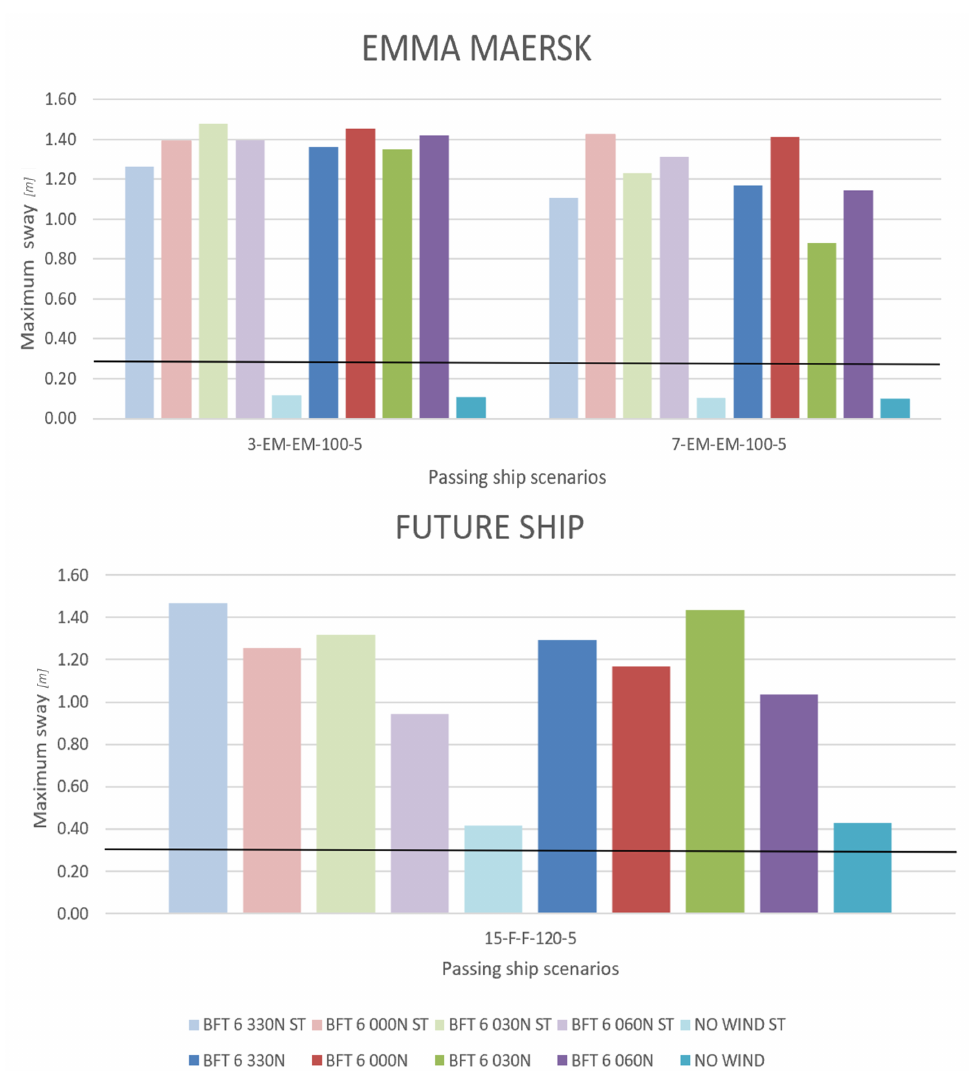
Figure 20. Maximum sway motion results for the Emma Maersk and the future vessel subjected to passing-ship conditions with ShoreTension ®